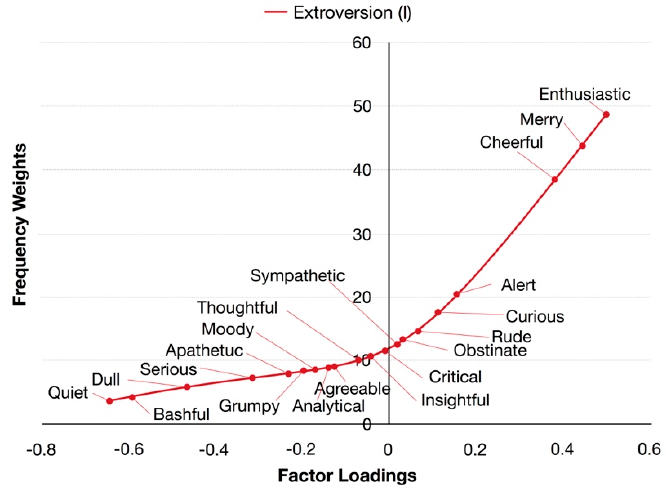
Figure 4. Frequency Weights vs. Factor Loadings graphs for Factor I.